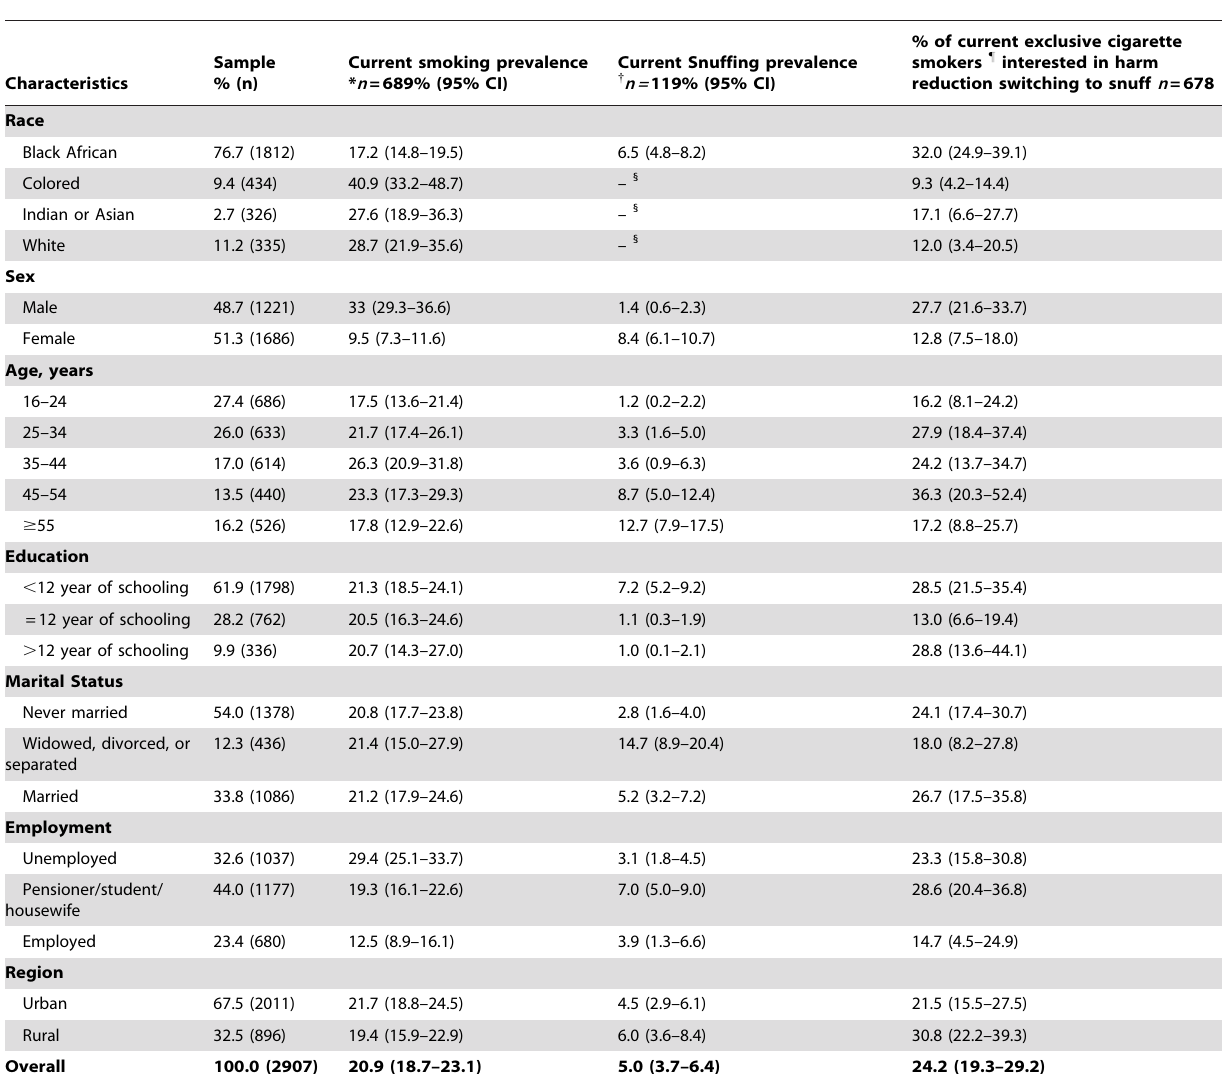
Table 1. Characteristics of study population, South African Social Attitudes Survey, 2007 ( n =2907).